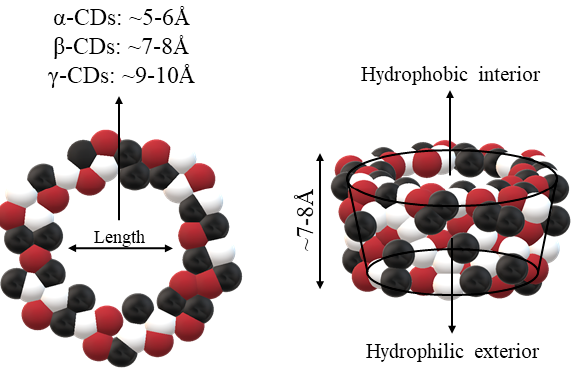
Figure 1. Schematic representations of cyclodextrins (CDs). Adapted from [13,21,22].